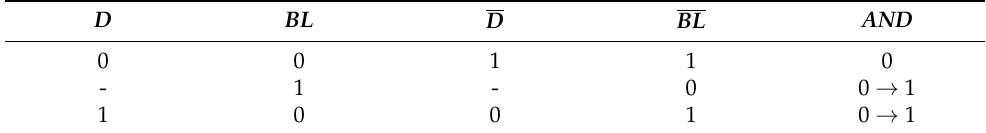
Table 2. The truth table of the special-purpose AND cell of Figure 11b. When evaluating this function, one needs to remember that BL is not a proper data signal but a selection one that allows to report the cell content D on the line. Every time BL =‘0’, the AND logic gate is disabled and the line is charged to ‘1’ (in particular, the pull-down is prevented from discharging the line in the case in which D =